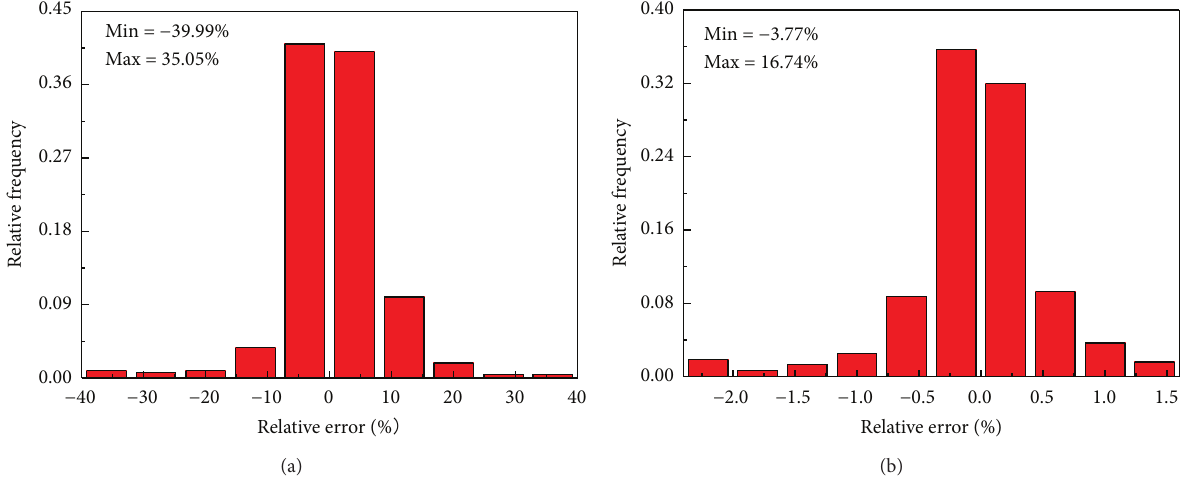
Figure 10: Distributions on prediction error by (a) constitutive model and (b) ANN